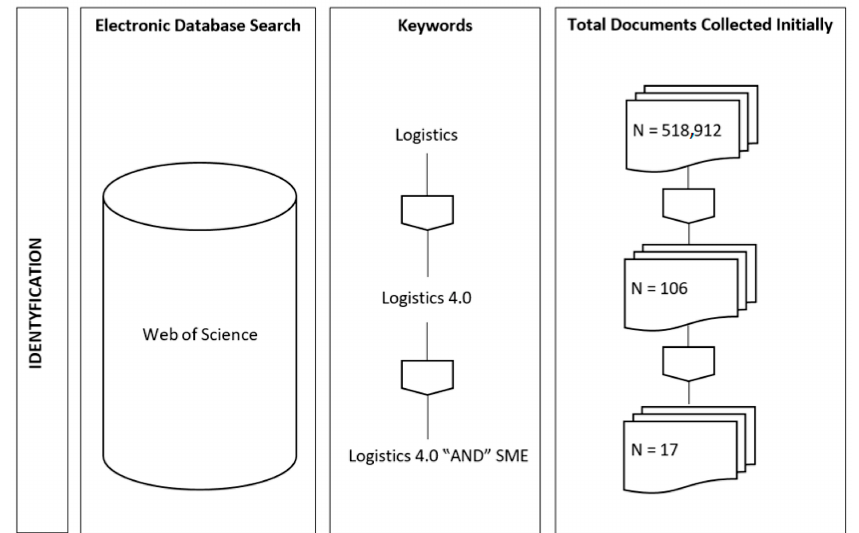
Figure 5. Identification stage of the PRISMA framework related to Logistics 4.0 in the SME sector. Source: own study, based on the PRISMA